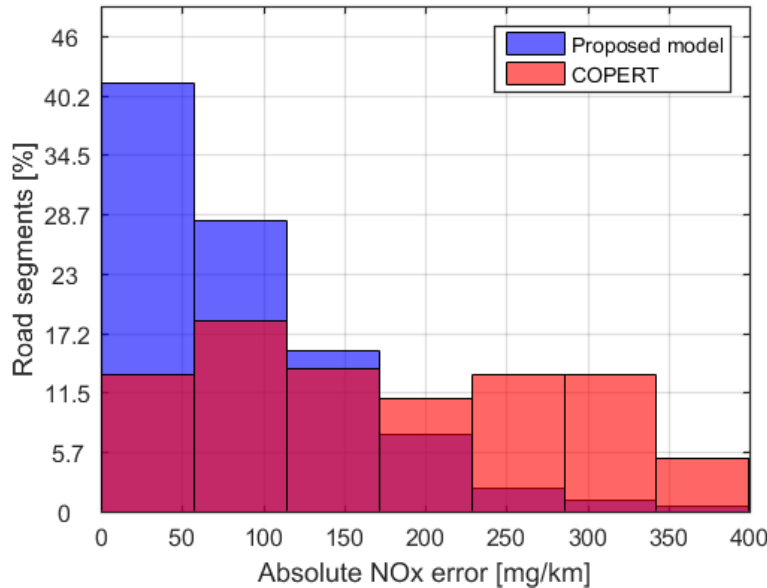
Figure 13. Comparison of errors between the proposed model and the COPERT